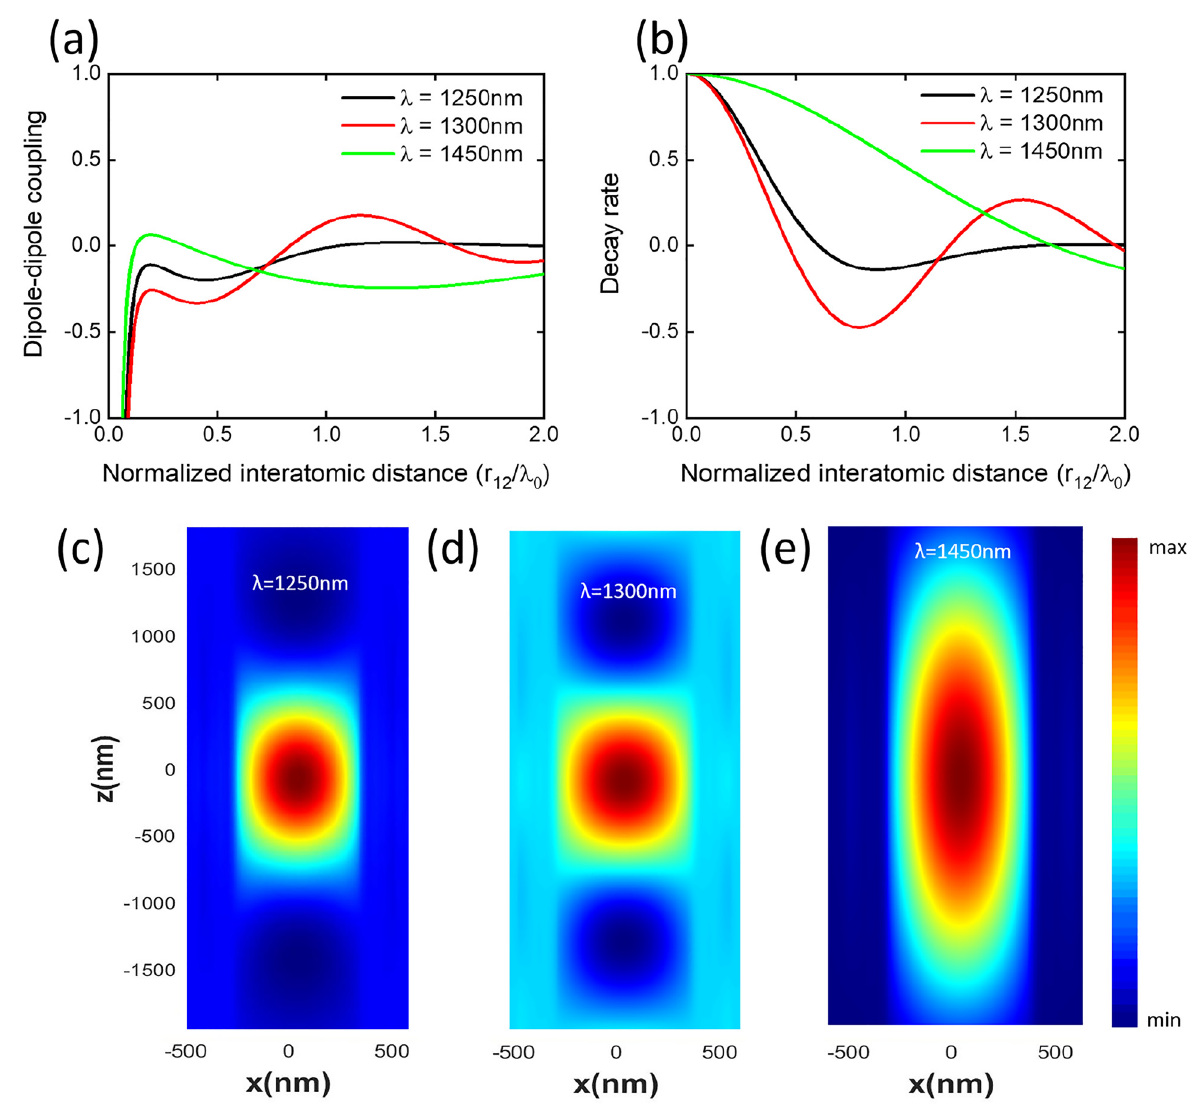
Figure 4: Coupling parameters of the rolled-up zero-index waveguide. (a) The dipole-dipole interaction and (b) the decay rate of emitters coupled to the rolled-up zero-index waveguide at different excitation wavelengths. Energy transfer resonance (ETR) of the rolled-up zero-index waveguide for the different excitation wavelengths: (c) 1250 nm, (d) 1300 nm, and (e) 1450